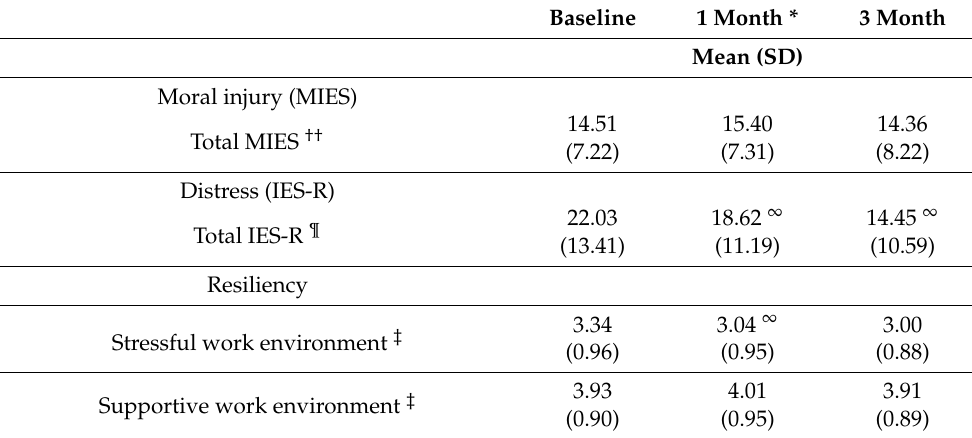
Table 2. Moral injury, distress, and resiliency scores over 3 months during initial COVID-19 US Surge in Baltimore, MD healthcare workers ( n =